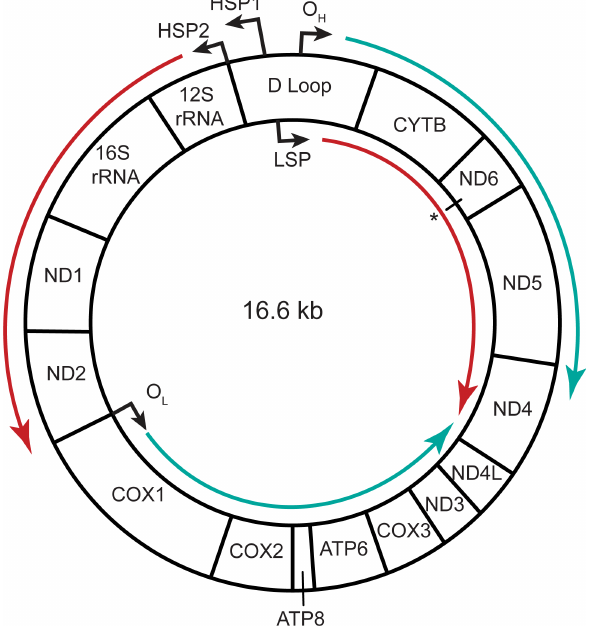
Fig 1. The mitochondrial genome (mtDNA). rRNA-encoding and protein-encoding genesare shown; tRNA- encoding genes are withheldfor clarity. Teal arrows depict the direction of mtDNA replication from the heavy strand or light strand origins of replication (O H , O L ); red arrows depict the direction of polycistronic transcription from the heavy strand or light strand promoters (HSP1/2, LSP). * —ND6 is the only protein- encoding gene on the light chain. Adapted from